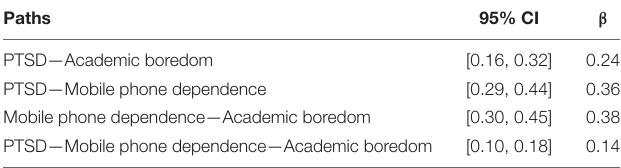
TABLE 2 | Bootstrap test of mediating